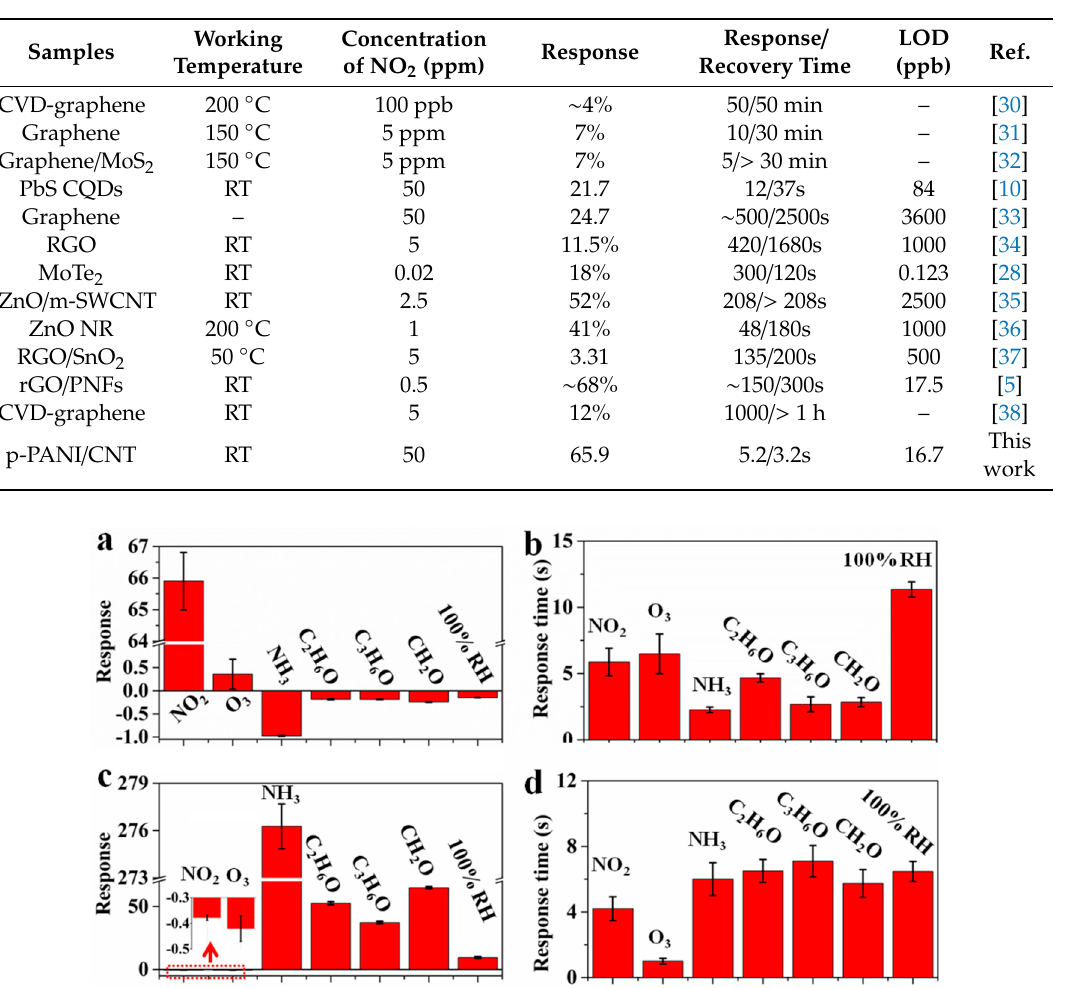
Table 1. Comparison of the chemiresistive sensor based on hierarchical p-PANI / CNT fibers and other sensors to NO 2 .